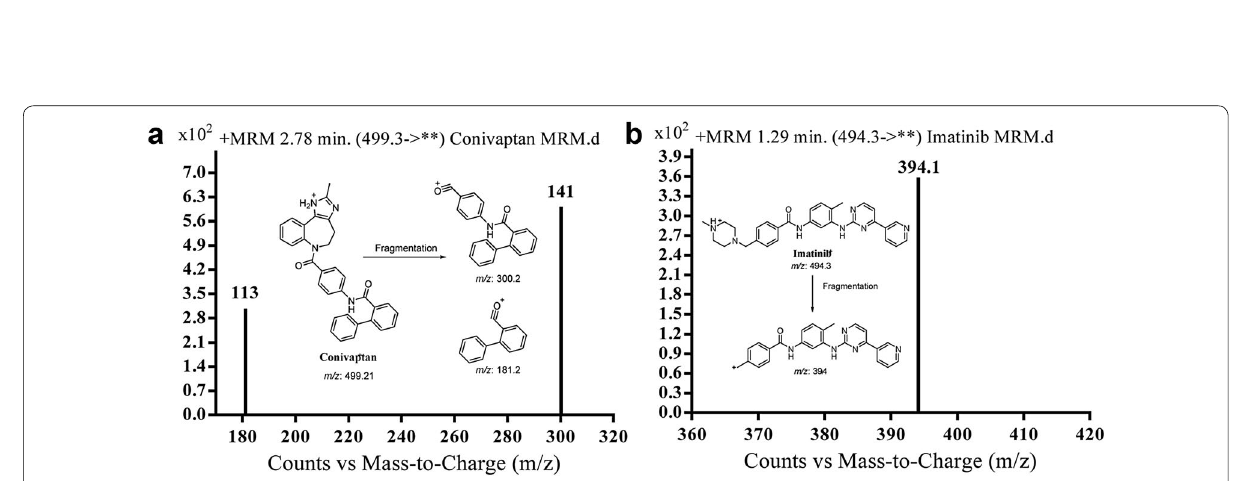
Fig. 3 MRM mass spectra of conivaptan ( a ) and IS ( b ) and the supposed fragmentation path